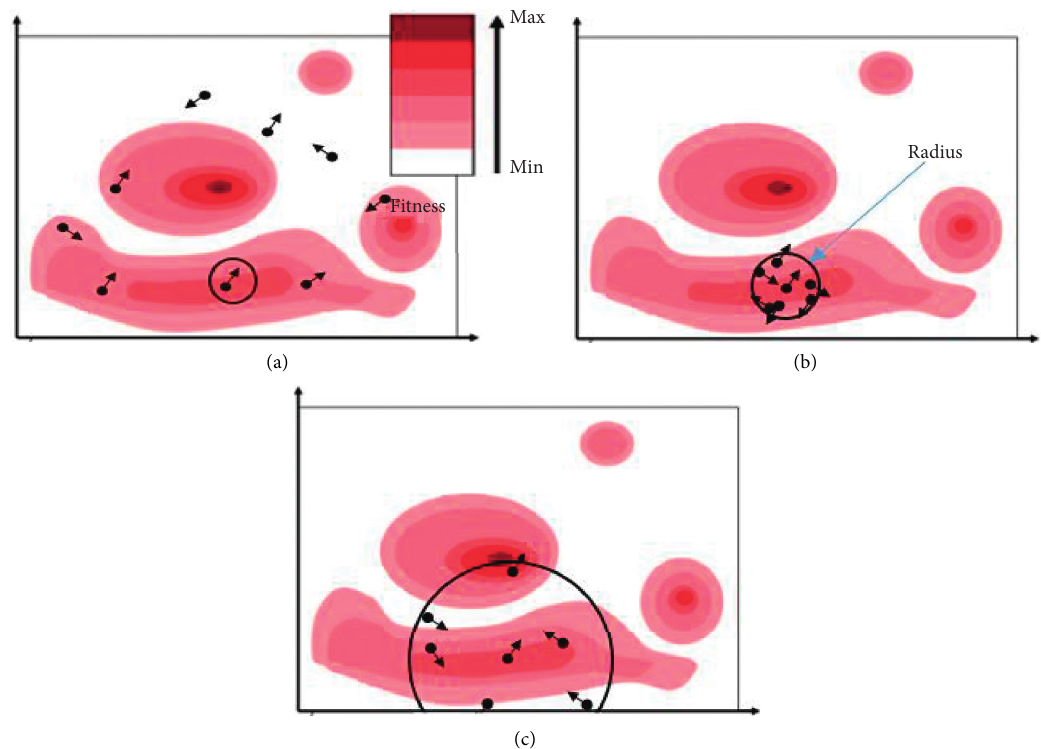
Figure 5: The proposed enhancement of EFFO algorithm. (a) Initial FFO. (b) Standard FFO. (c) Enhanced FFO (EFFO).